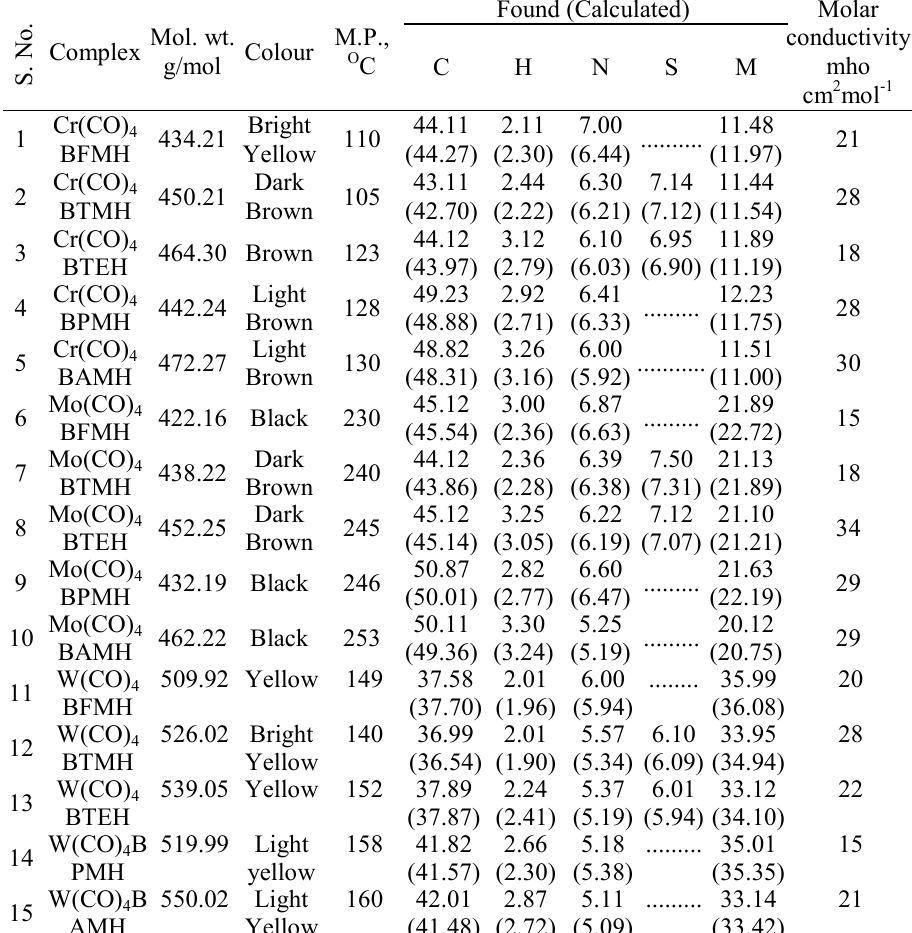
Table 1. Analytical data and some physical properties of the synthesized complexes cis- [M(CO) 4